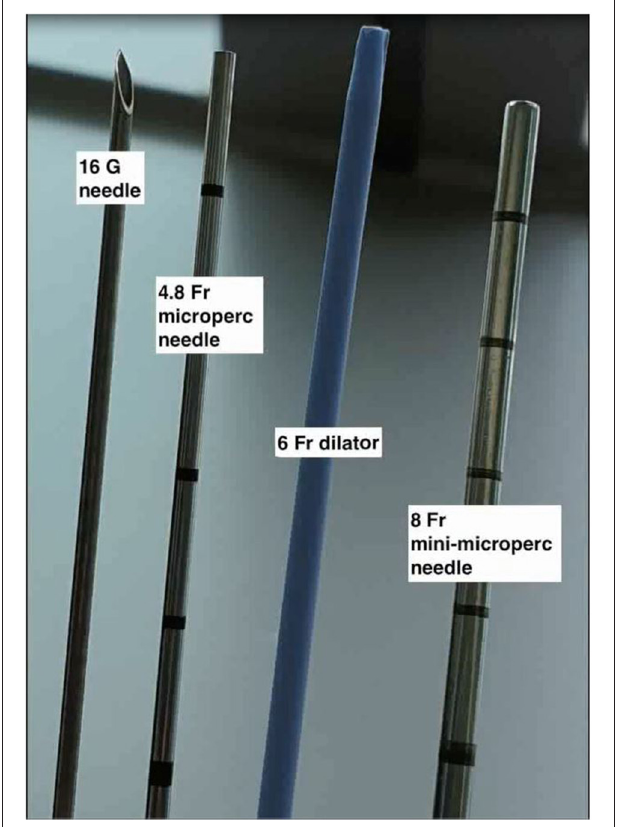
FIGURE 1 | The Mini-micro perc set consisting of puncture needles, guidewire, and connectors. FIGURE 2 | The micro and mini-microperc